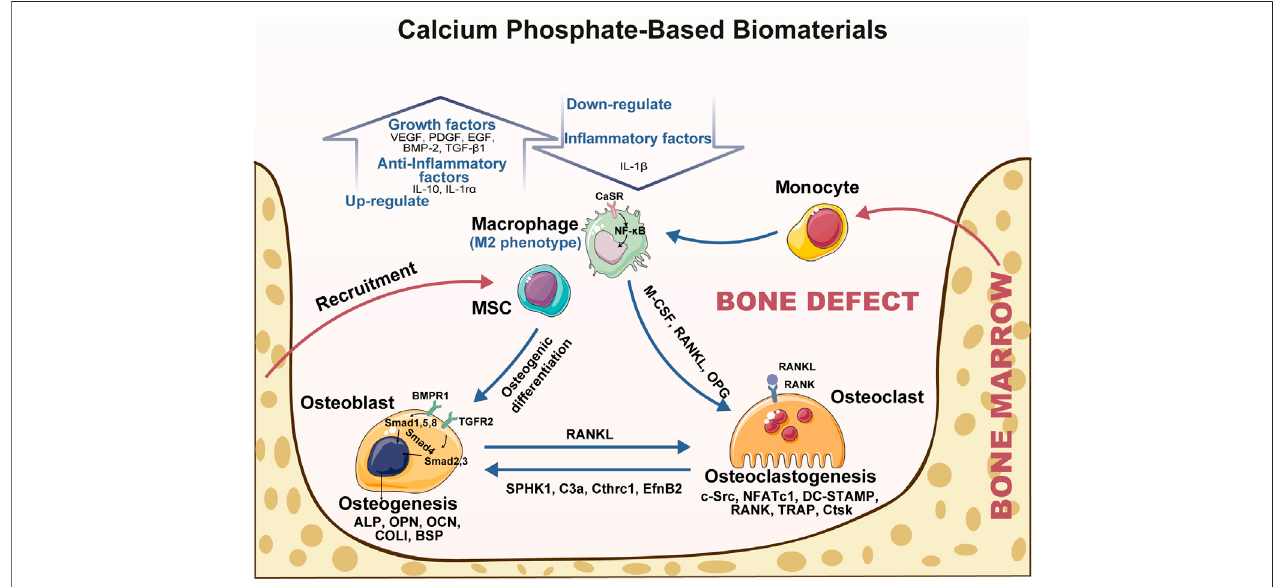
FIGURE2| The interactions betweenCaP-basedbiomaterialsand bone healingresponse.TheosteoinductivityofCaP-based biomaterialscanbe “ programmed ” by theirphysico-chemicalpropertiesand arenecessaryfor modifying thebehaviorofimmune cells, osteoclasts, and MSCs/osteoblasts.Underthe simulation withCaP- basedbiomaterials,theexpressionofin fl ammatoryfactors(IL-1 β )isdecreased,andtheproductionofanti-in fl ammatorycytokine(IL-10,IL-1r α ),aswellasgrowthfactors (VEGF, PDGF, EGF, BMP-2, and TGF- β 1) is increased in macrophages. The surface structure and crystallinity of CaP-based biomaterials can be sensed by osteoclasts and regulate their metabolically active and resorption capacity. All above synergistically create a pro-osteogenic micro-environment leading to effects on bone formation. Abbreviation: ALP, alkaline phosphatase; BMP-2, bone morphogenetic protein two; BSP, bone sialoprotein; CaSR, calcium-sensing receptor; C3a, complement component3a; Cthrc1, collagen triple helix repeat containing one; COL-I, collagen I; Ctsk, cathepsin k.DC-STAMP, dendritic cell-speci fi ctransmembrane protein; EfnB2, EphrinB2; EGF, epidermal growth factor; IL, interleukin; SPHK1, sphingosine-kinase one; MCP-1, monocyte chemoattractant protein-1; M-CSF, macrophage colony-stimulating factor; NFATc1, nuclear factor of activated T cells one; OCN, osteocalcin; OPN, osteopontin; OPG, osteoprotegerin; PDGF, platelet derivedgrowthfactor;RANKL,receptoractivatorofNF- κ Bligand;TGF- β ,transforminggrowthfactorbeta;TNF- α ,tumornecrosisfactor- α ;TRAP,tartrate-resistantacid phosphatase; VEGF, vascular endothelial growth